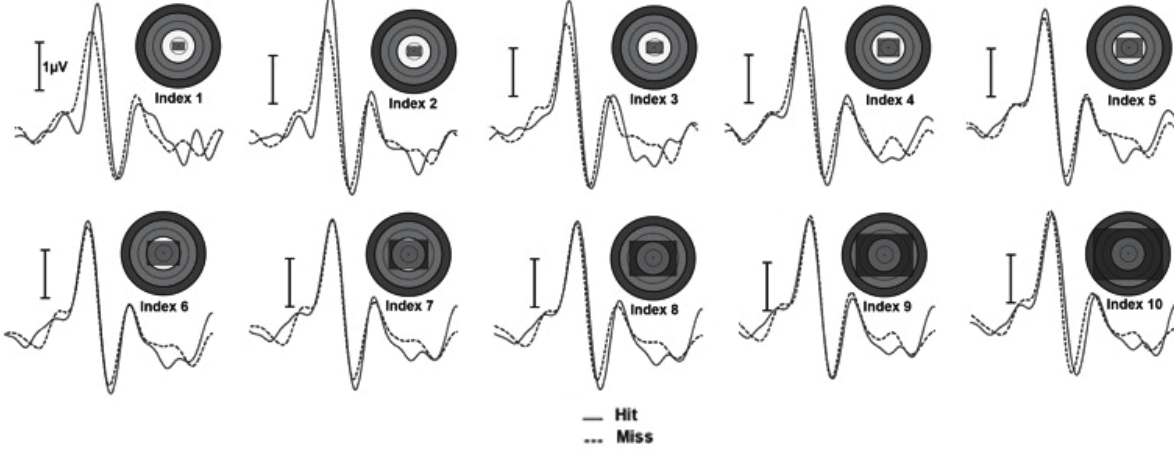
FIGURE 2. Grand averages of ERPs, which were aligned to